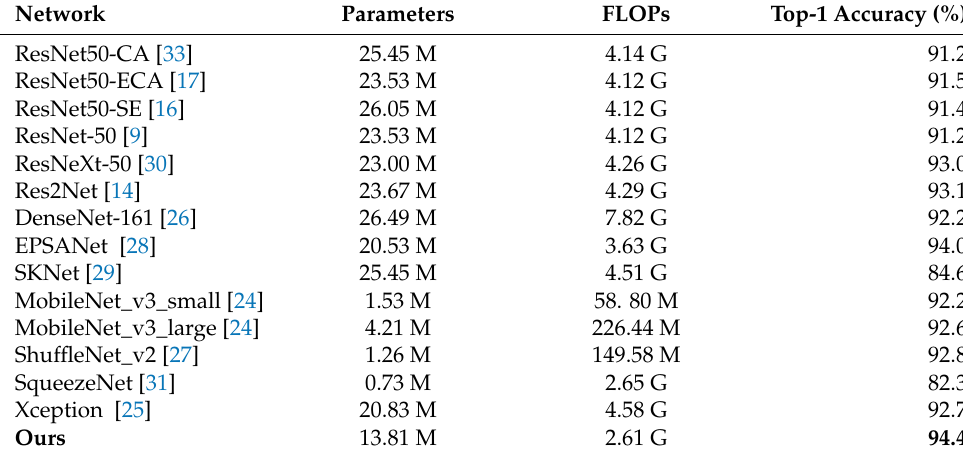
Table 8. Comparison experimental results of MFANet and various neural networks on the CIFAR- 10